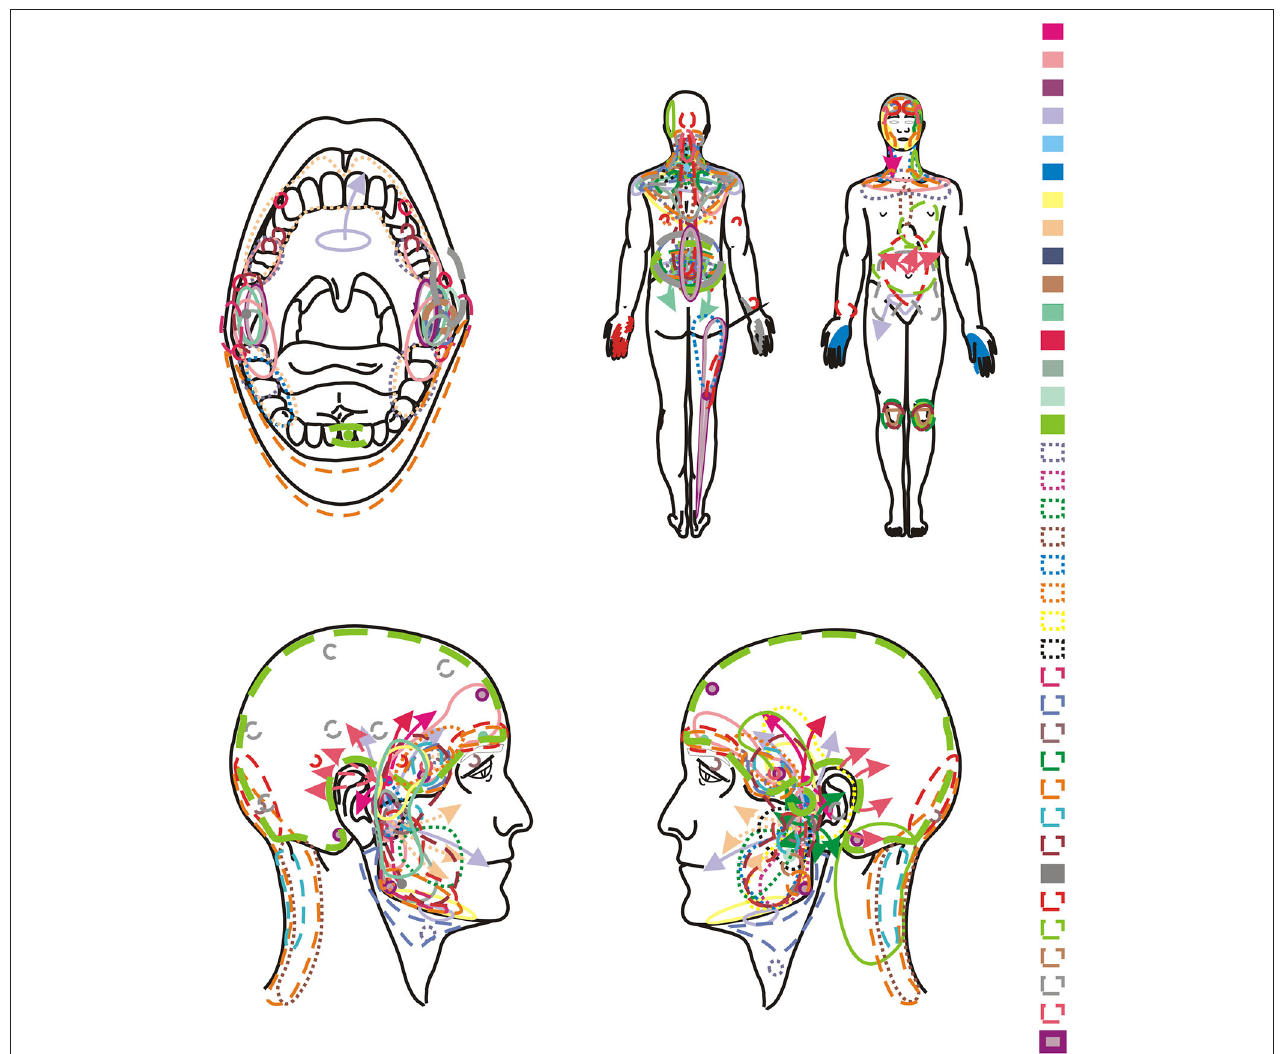
FIGURE 1 | Orofacial and general pain location in group of women ( n =